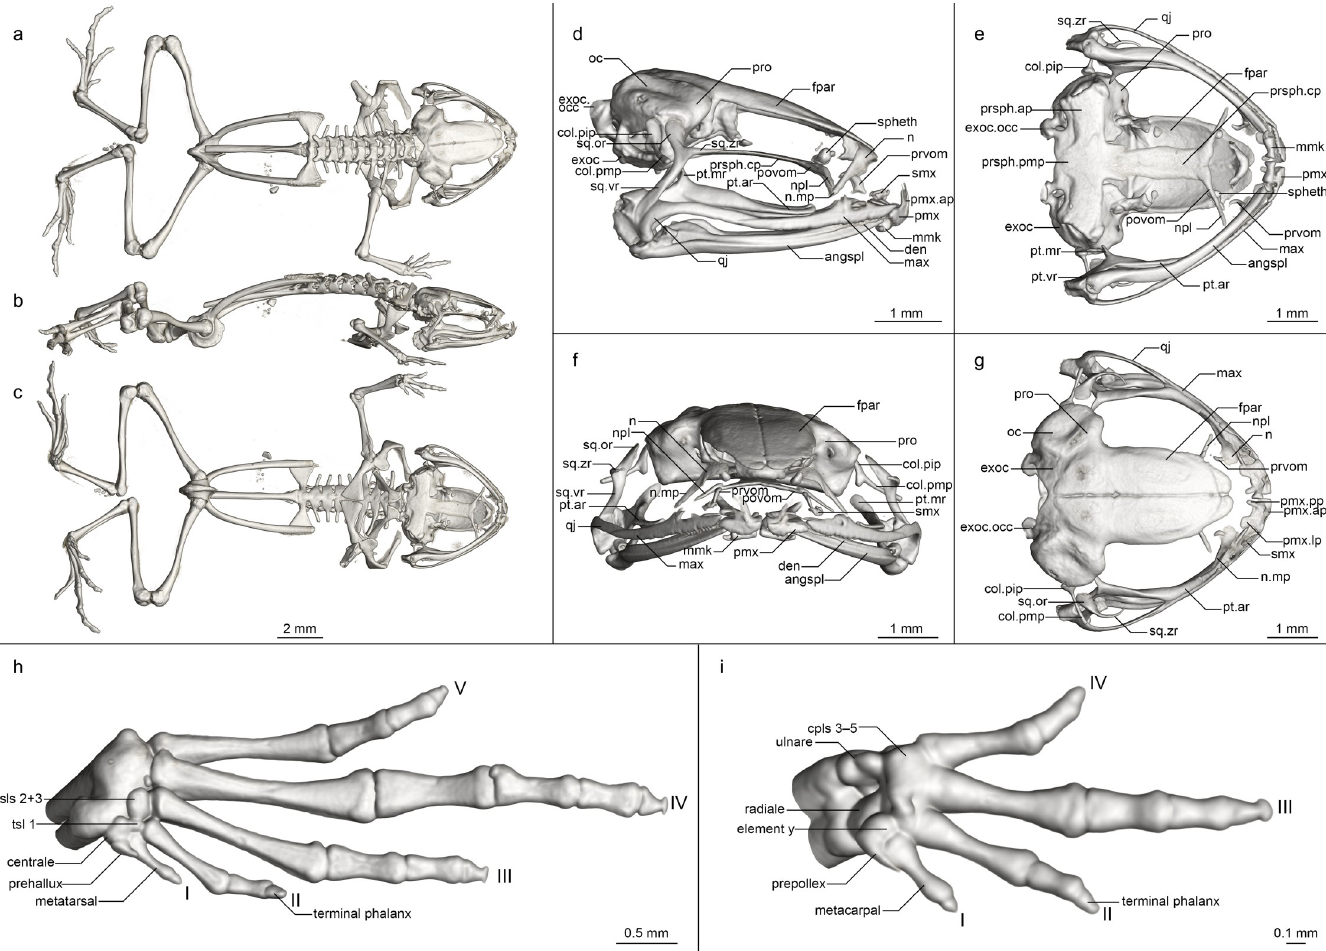
Fig 9. Osteology of Mini ature gen. et sp. nov. holotype (ZSM 86/2004). (a-c) Whole skeleton in (a) dorsal, (b) lateral, and (c) ventral view. (d-g) Skull in (d) lateral, (e) ventral, (f) anterior, and (g) dorsal view. (h) Foot in ventral view. (i) Hand in ventral view. For abbreviations, see Fig 6. border, and M . scule sp. nov. by proportionally smaller nasals and braincase, broader quadra- tojugal-maxillary contact, and vertical dorsal process of premaxilla (vs anterior).